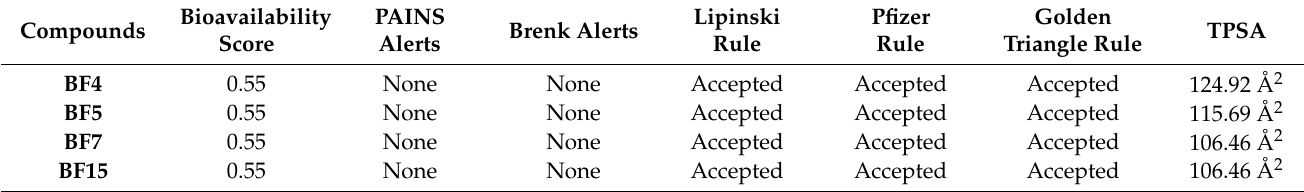
Table 3. Drug-likeness profile of BF4 , BF5 , BF7 and BF15 furan-1,3,4-oxadiazole